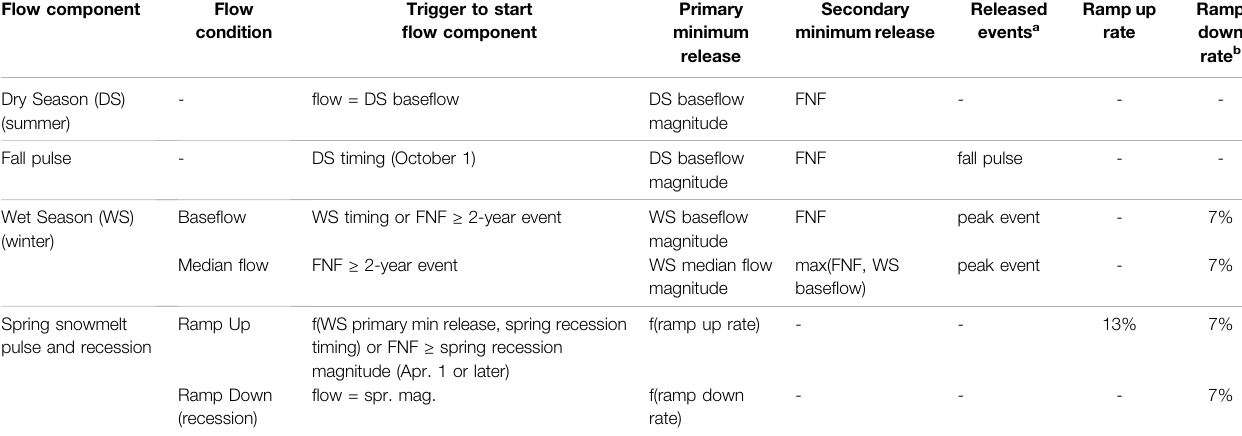
TABLE 2 | Minimum releases, ramping rates, released events, and sub-season change cues to implement functional fl ows for different seasons and sub-seasons. Flow